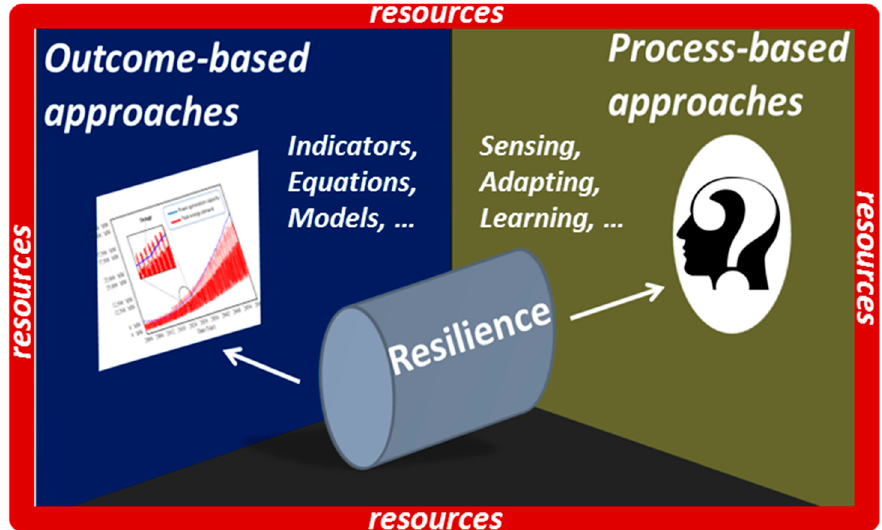
Figure 1. Integrated approach of resilience. Resilience approaches may be based on outcome- or process-based approaches under resources constraints. The purpose is to nest process-based approaches into outcome-based approaches under resources constraints in order to have an integrated view of resilience that fits both approaches.